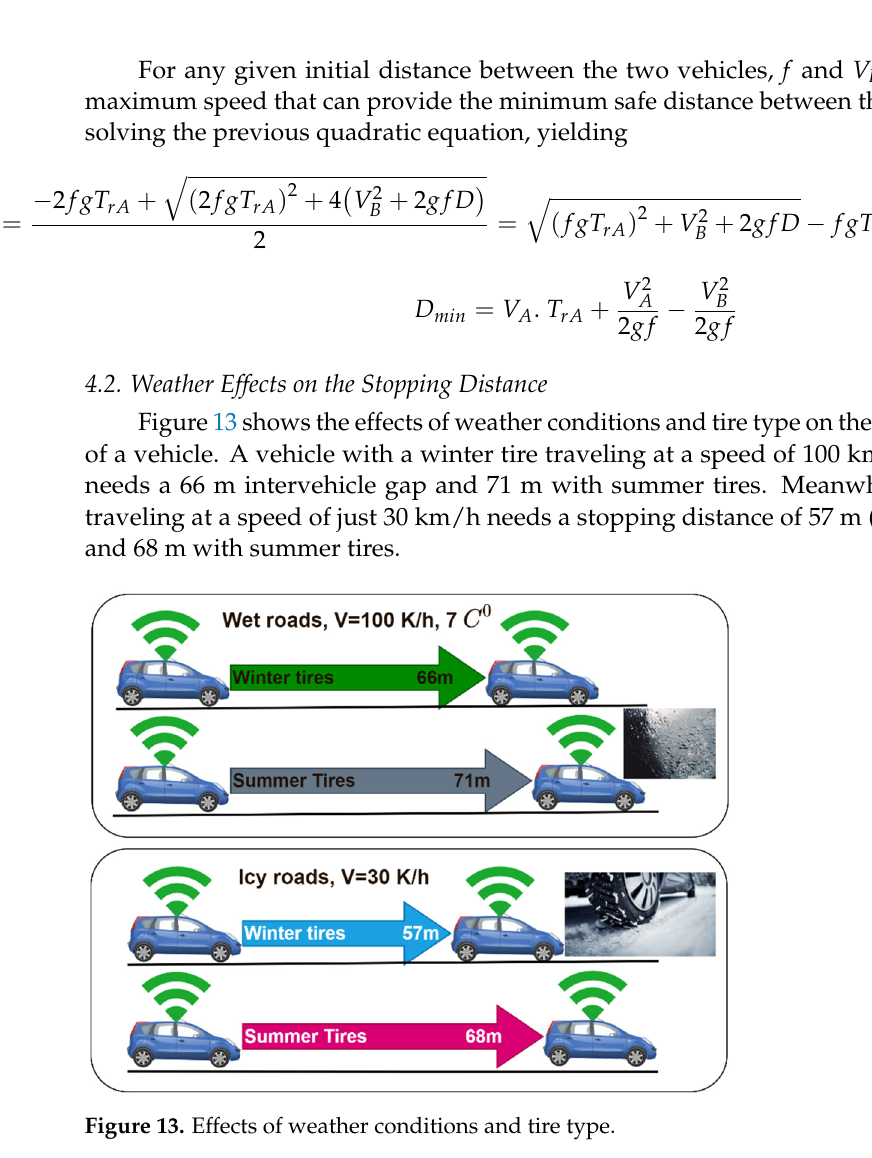
Figure 14. Maximum speed of the following vehicle for different speeds of the followed vehicle for different initial distances between the two vehicles when the driver reaction ( 𝑇 (cid:3045)(cid:3002) = 1 s ) . We calculated the same values in the case of foggy weather, as shown in Figure 15. As it can be seen, the increase in the driver’s reaction time significantly increases the stop- ping distance; hence, the maximum allowed speed of the following vehicle must be de- creased. For example, if the followed vehicle is traveling at a speed of 100 km/h and the initial separating distance with the following vehicle is 100 m, then the maximum allowed speed of the following vehicle is 150 km/h in the case of dry asphalt in clear weather while